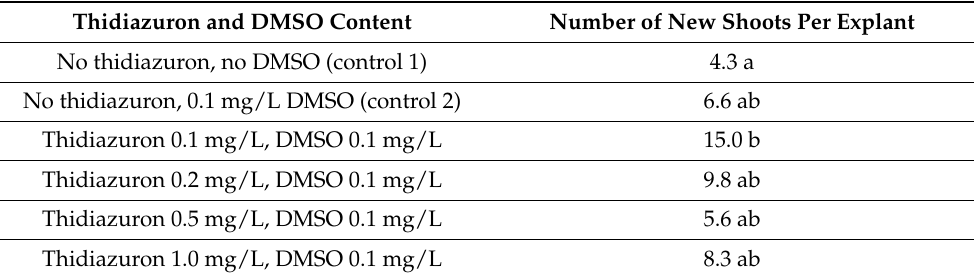
Table 3. Xerophyllum asphodeloides shoot multiplication over four months for three seed sources (1, 2, and 3) on 1 MS medium without PGRs varying in thidiazuron content. 2